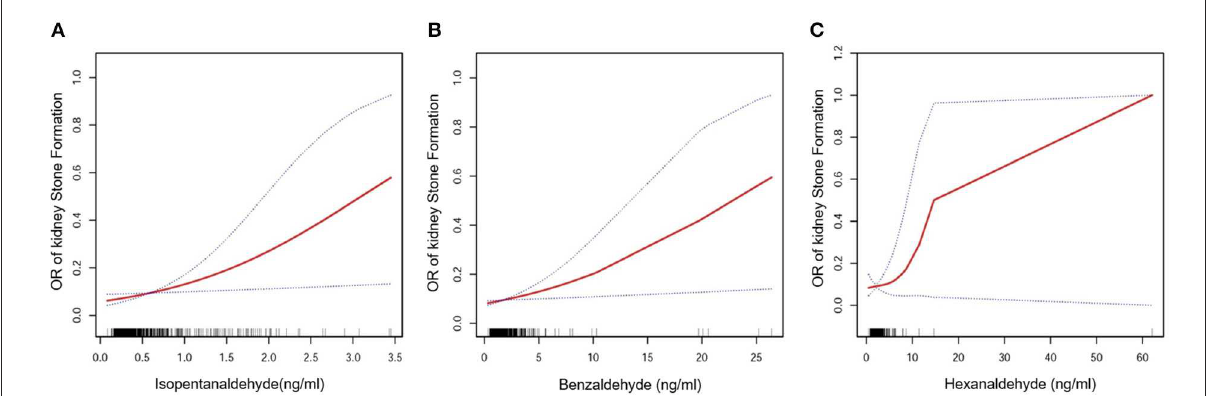
FIGURE2 Isopentanaldehyde and total kidney stone formation dose-response relationship (A) . Benzaldehyde and total kidney stone formation dose-response relationship (B) . Hexanaldehyde and total kidney stone formation dose-response relationship (C) . The area between the upper and lower dashed lines is indicated as the 95% CI. The red line is connected by the magnitude of the aldehyde concentration into a continuous line. Adjustments were made for all covariates except for effect